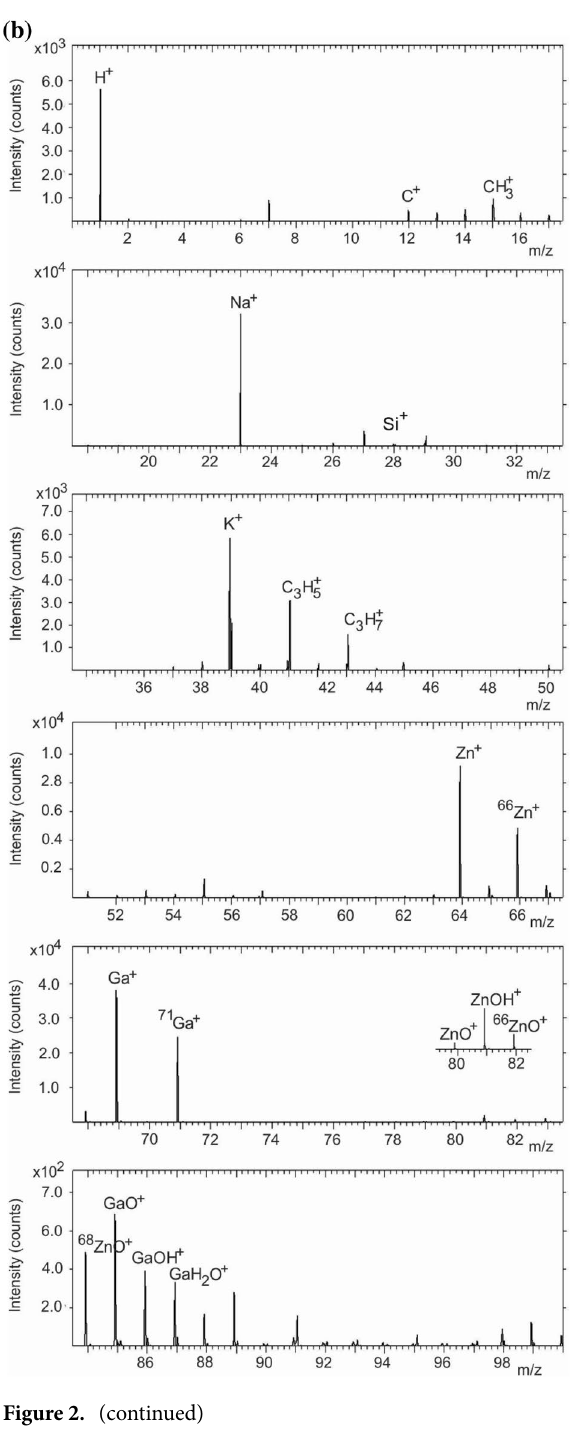
Figure 4a,b show the negative secondary ion spectra obtained from the 1 and 7 wt% GZO films, respectively. There is evidence of compliance with the FAR rule in both films. In the 1 wt% film (Fig. 4a), peaks originat- ing from within-the-rule fragments ZnO ‒ , 66 ZnO ‒ , 68 ZnO ‒ and ZnO 2 ‒ appear at m/z 79.918, m/z 81.913, m/z 83.913 and m/z 95.910, respectively. The other peaks are assigned to ZnOH ‒ ( m/z 80.926), GaO ‒ ( m/z 84.919), COGa ‒ ( m/z 96.919), H 2 SiGa ‒ (m/z 98.915) as well as H ‒ ( m/z 1.010), O – ( m/z 15.998), OH – ( m/z 17.006), C 2 ‒ ( m/z 24.004), C 2 H ‒ ( m/z 25.002), C 2 O ‒ ( m/z 39.996), CHO 2 ‒ ( m/z 44.998) and CH 2 OF ‒ ( m/z 49.010). In the 7 wt% film (Fig. 4b), within-the-rule fragments ZnO ‒ , 66 ZnO ‒ , 68 ZnO ‒ and ZnO 2 ‒ appear at m/z 79.922, m/z 81.918, m/z 83.919 and m/z 95.917, respectively. The other peaks are assigned to ZnOH ‒ ( m/z